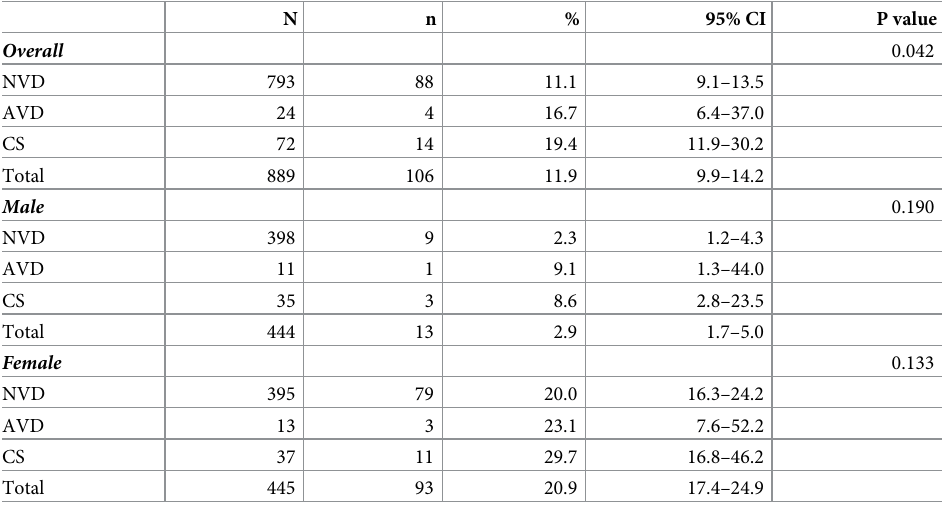
Table 5. Prevalence of obesity in each mode of delivery category among study participants, by